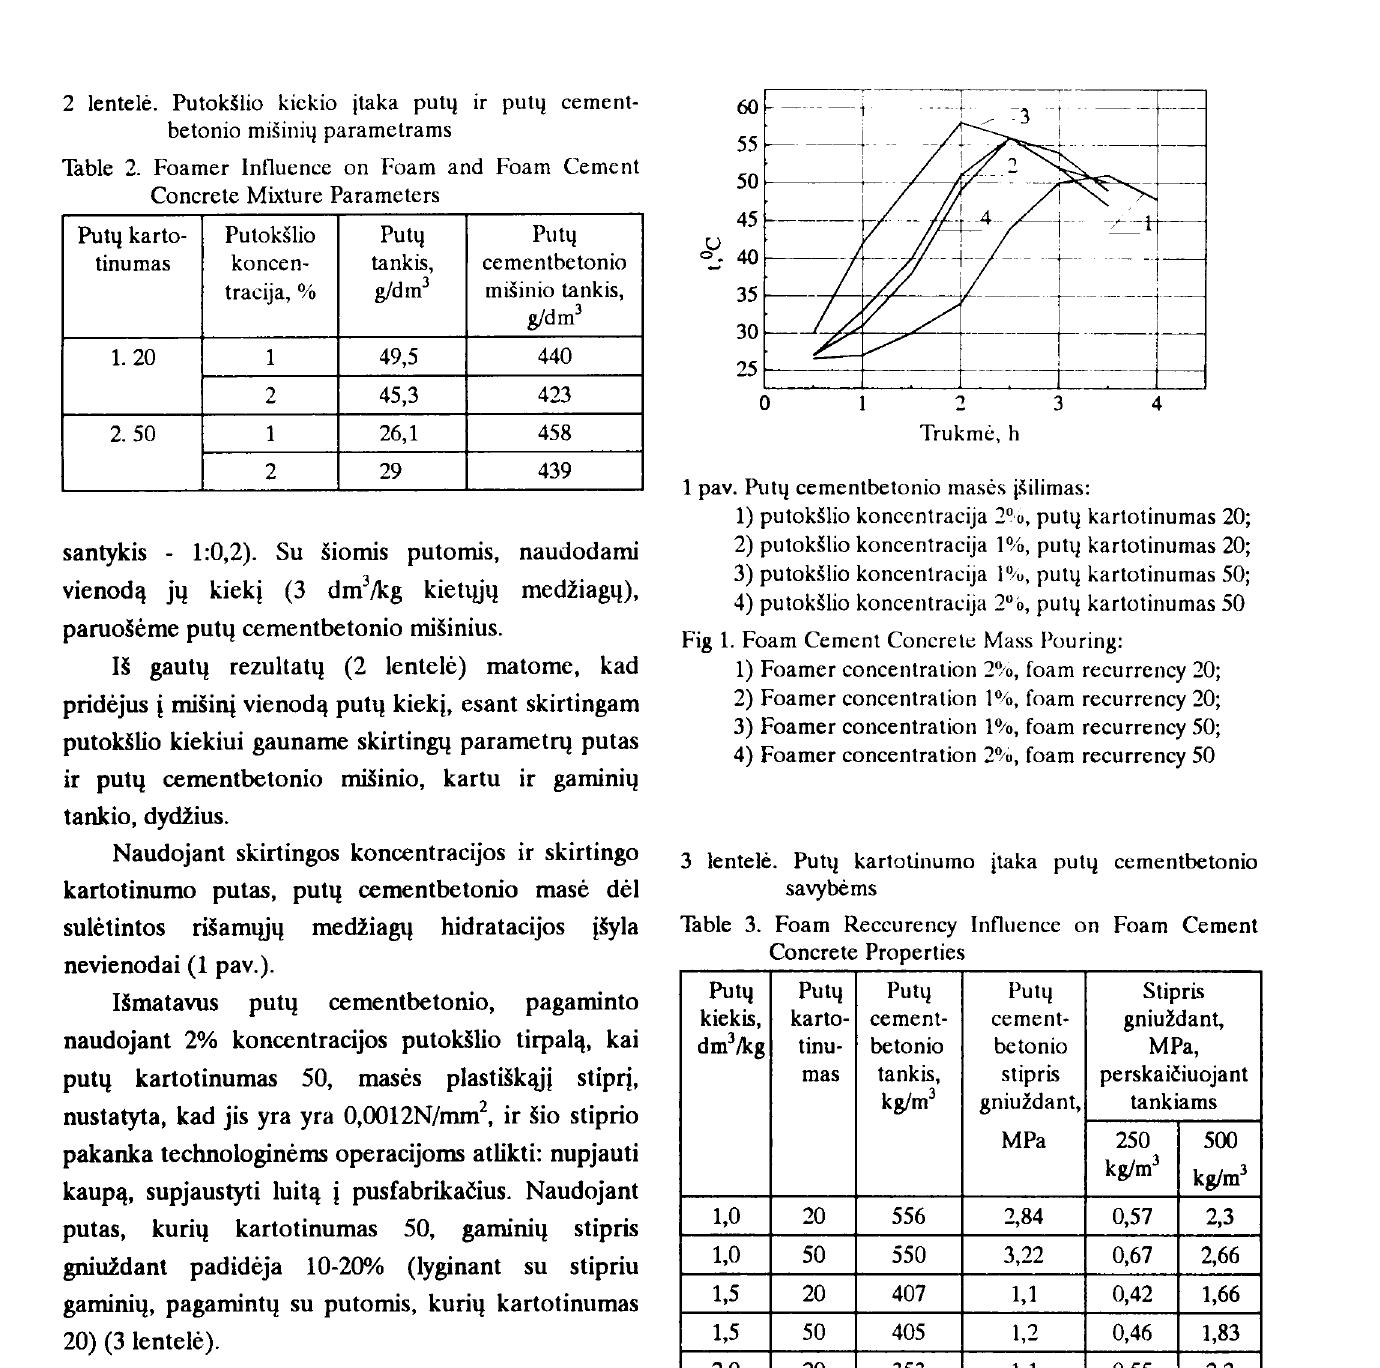
Table 2. Foamer Influence on Foam and Foam Cement Concrete Mixture Parameters